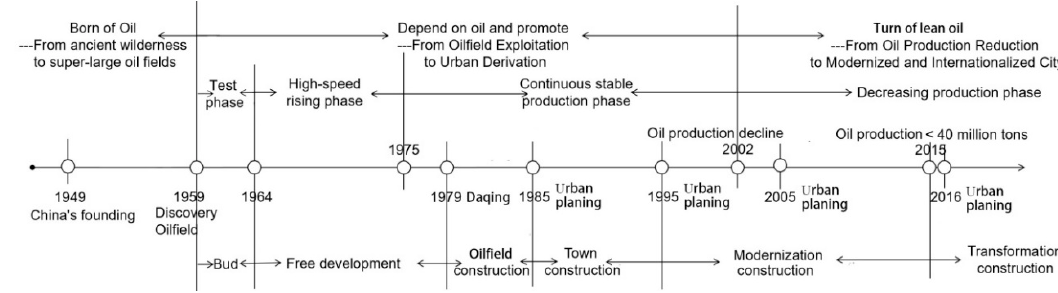
Figure 2. Urban development context of the study area.